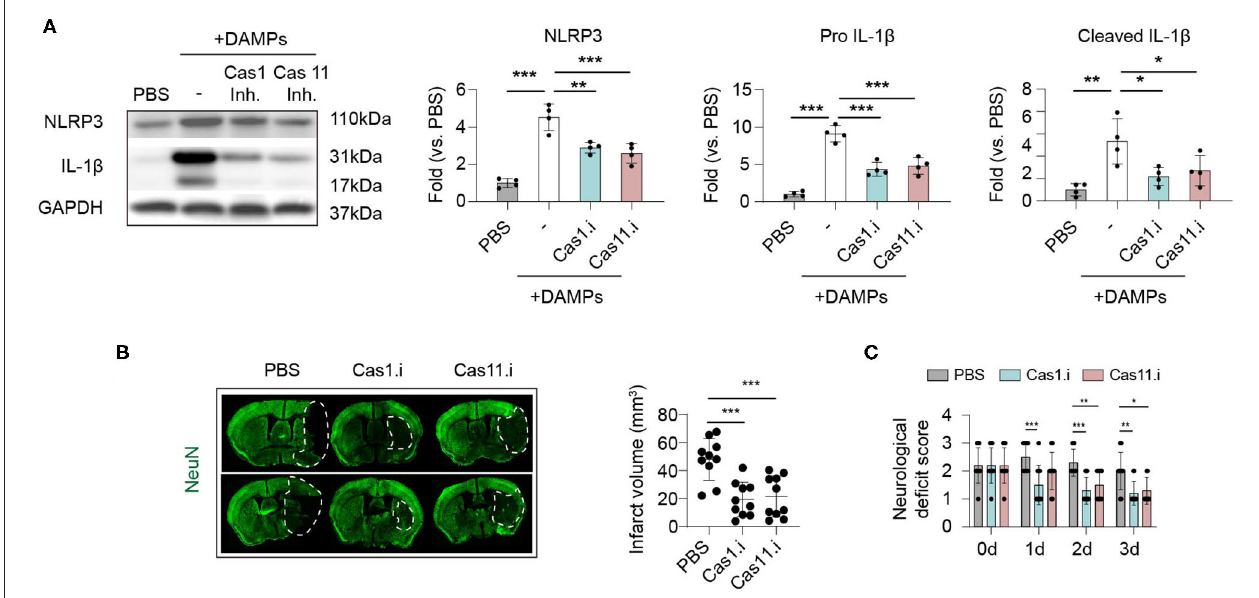
FIGURE 5 | Inhibiting Caspase 1/11 signaling hinders inflammasome activation induced by brain ischemia and protects against ischemic stroke. (A) Primary cultured bone-marrow-derived macrophages were treated with Caspase 1 inhibitor Belnacasan (1 µ M) or Caspase 11 inhibitor Wedelolactone (5 µ M) overnight before inflammasome induction. Danger-associated molecular patterns (DAMPs) were prepared from the ipsilateral brain of mice at 3 d after tMCAO and treated to macrophages for 2h. Inflammasome markers of NLRP3 and IL-1 β were analyzed with western blotting. Data were normalized to the gray scale of GAPDH. Experiments were repeated three times. * P < 0.05, ** P < 0.01, *** P < 0.001 in One-way ANOVA . (B,C) Wild-type C57/Bl6 mice were subjected to tMCAO and Caspase 1 inhibitor Belnacasan (10 mg/kg) or Caspase 11 inhibitor Wedelolactone (10 mg/kg), or equal volume of PBS was treated to mice at 1h after reperfusion. N = 10 mice in each group. * P < 0.05, ** P < 0.01 in One-way ANOVA . (B) Mice were sacrificed at 3 d after tMCAO, and infarct volume was assessed with immunostaining of NeuN. (C) Neurological deficit score was assessed from 0 to 3 d after tMCAO. N = 10 mice in each group. * P < 0.05, ** P < 0.01 in Two-way ANOVA